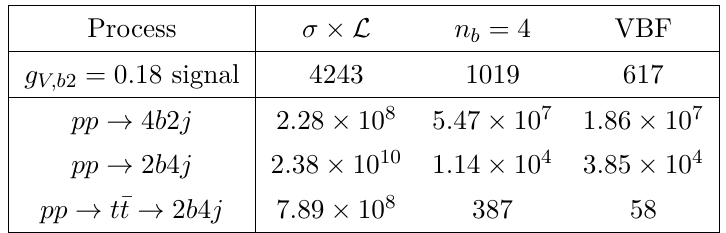
Table 9 . The cut efficiencies of b-tagging and VBF at 14 TeV LHC are demonstrated. Here, the total integrated luminosity is assumed to be L = 3 ab − 1 . b-tagging efficiency is (cid:15) mis-tagging rate is (cid:15) = 0 . 001 . miss